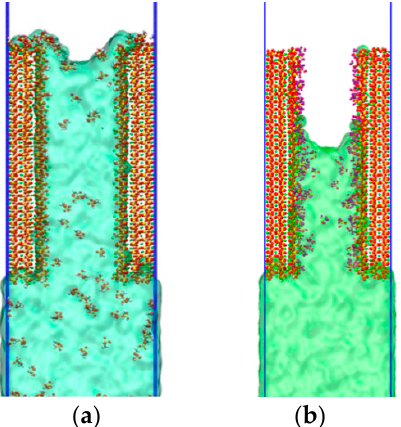
Figure 9. Screenshots of two models of water molecules at 800 ps. ( a ) Silicone emulsion, ( b ) Silicone